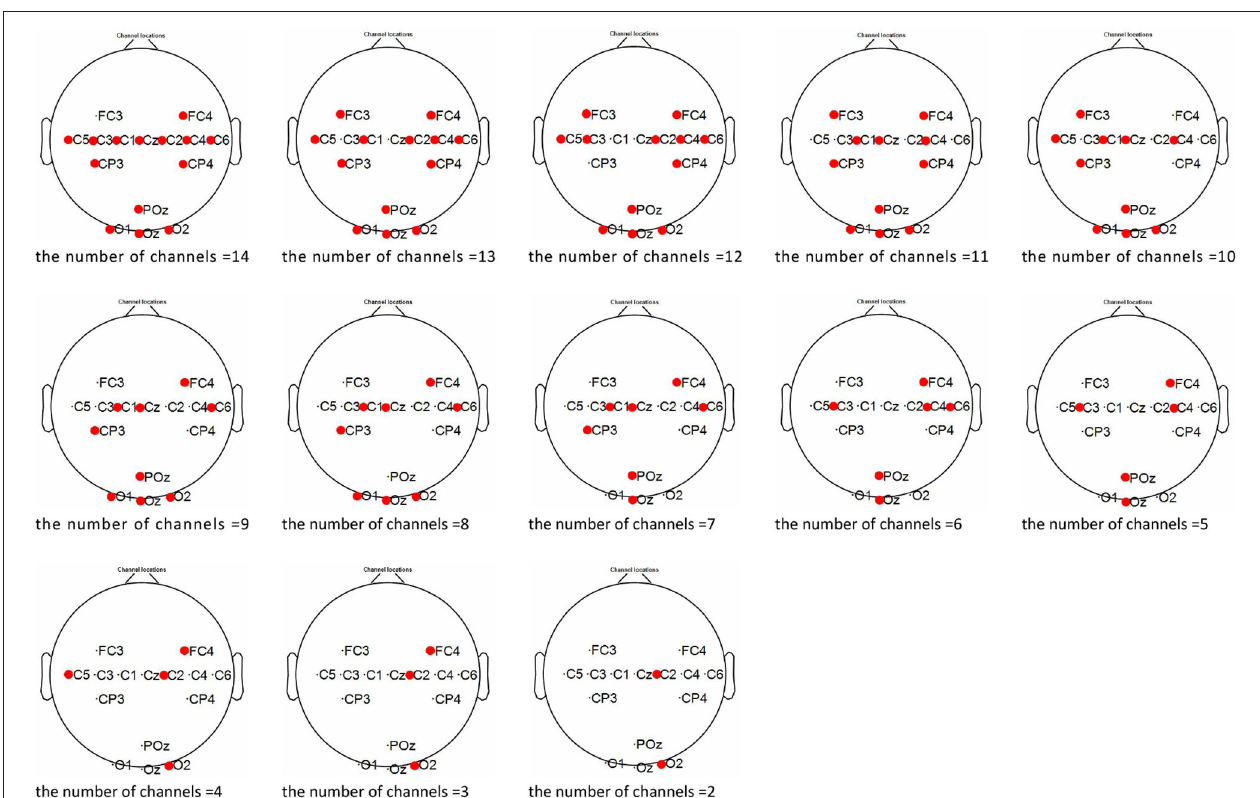
FIGURE 7 | The distribution diagrams in conditions of different numbers of selected